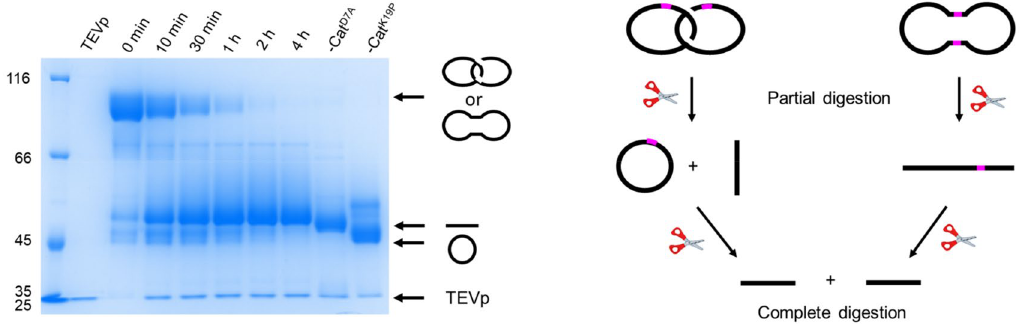
Figure 3. SDS-PAGE of the TEV protease (TEVp) digestion of Is PETase-Cat and a diagram of the expected partial and complete digestion products of a catenane and cyclic dimer (see Fig. S2 for the original gel).